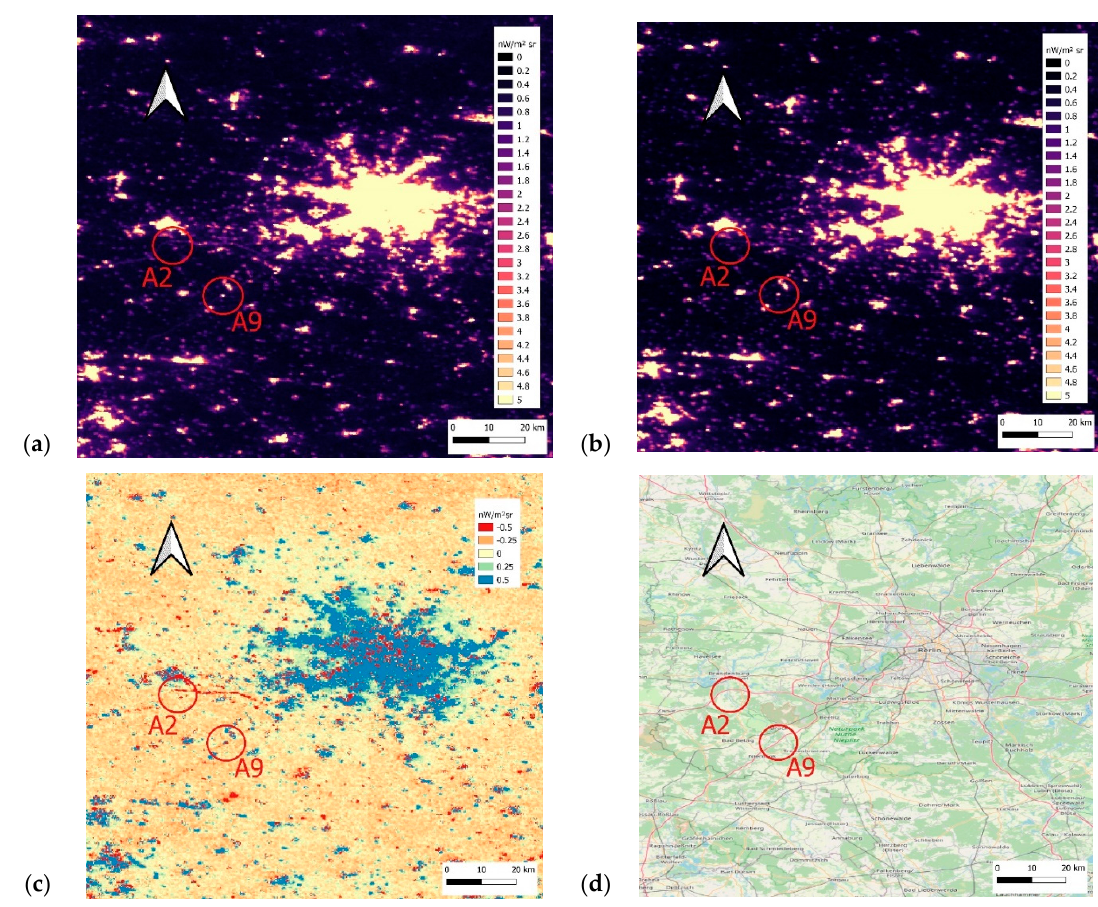
Figure 7. Visible Infrared Imaging Radiometer Suite (VIIRS) Day–Night Band (DNB) monthly composites for ( a ) March 2017, ( b ) March 2020, ( c ) the subtraction of the March 2017 data from the March 2020 data and ( d ) a map of the area. Major motorways to the south and west are marked with red circles.